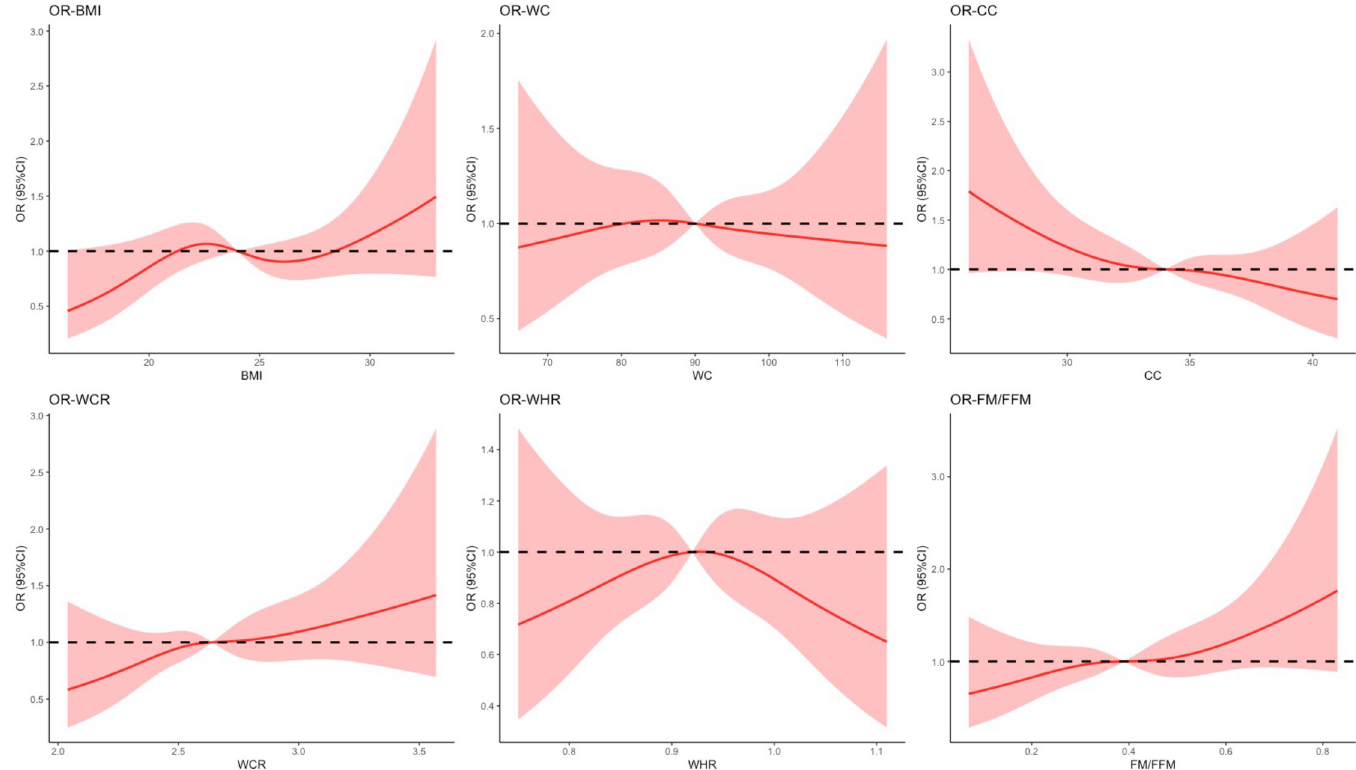
Fig 1. Restricted cubic splines assessing the association between obesity-related anthropometric indicators and cognitive function. Abbreviations: BMI: body mass index; WC, waist circumference; CC: calf circumference; WHR: waist to hip ratio; WCR: waist to calf circumstance ratio; FM/FFM: fat to fat-free mass. Age, sex, education, marital status, living situation, drinking, smoking, physical activity, hypercholesterolemia, hypertension, diabetes, stoke, nutrition and depression were adjusted